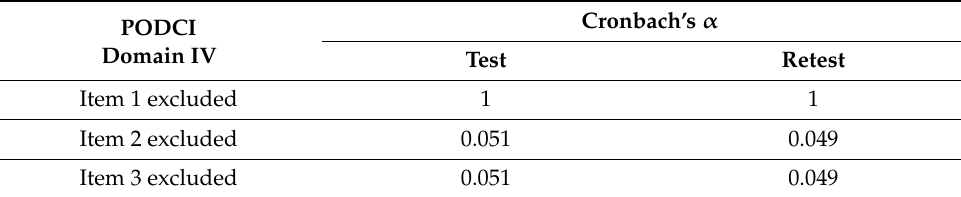
Table 4. Internal consistency (Cronbach’s α ) for test and retest sessions for PODCI domain IV.